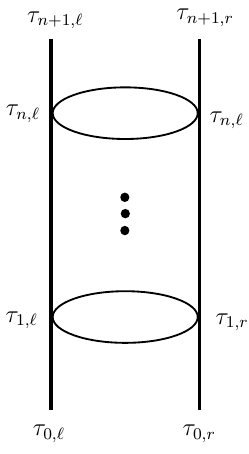
Figure 11 . A ladder diagram with n rungs. Vertices on the left and right sides of the ladder are labeled by complex time parameters (cid:28) i;l and (cid:28) i;r , i = 0 ; : : : ; n +1. To construct a contribution to the double commutator of eq. (8.11), we take (cid:28) 0 ;l = " , (cid:28) n +1 ;l = it 1 , (cid:28) 0 ;r = (cid:12)= 2 " , and (cid:28) n +1 ;r = (cid:12)= 2+ (cid:6) (cid:6) it 2 . As explained in the text, to get a nonzero contribution, all the (cid:28) i;l and (cid:28) i;r must then be on the left or right \rail" of the complex time contour of (cid:12)gure 10, arranged in increasing order of real